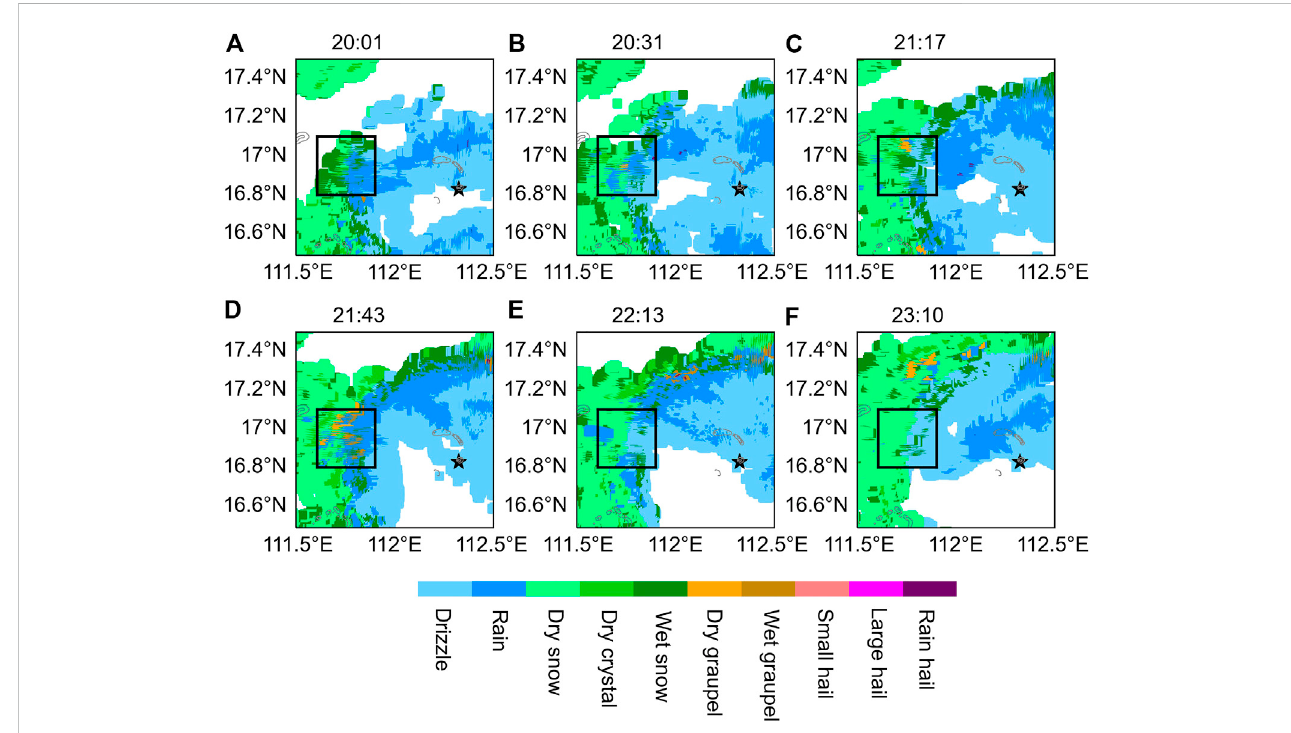
FIGURE 5 Distribution of hydrometeors at 4.3 ° elevation (A) 20:01, (B) 20:31, (C) 21:17, (D) 21:43, (E) 22:13, and (F) 23:10 on 16 October.